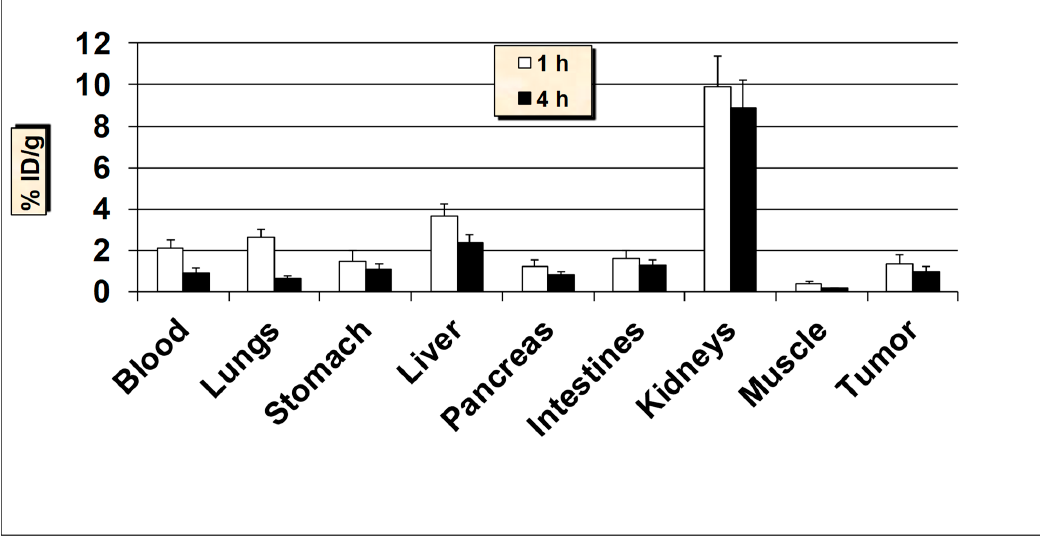
Molecules 2019 , 24 , x